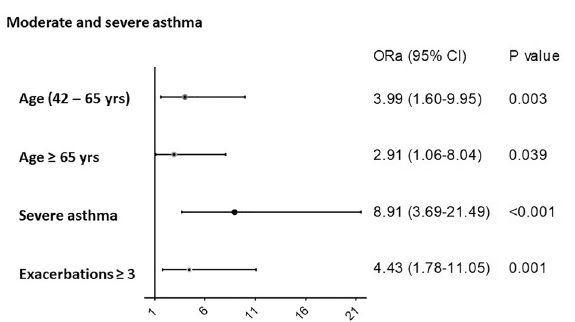
Figure 3. Factors associated with bronchiectasis in all subjects (moderate and severe asthma). ORa: adjusted odds ratio. CI: confidence interval. Model: χ 2 = 73.64, p < 0.001. Model adjusted by gender, atopy, sinusitis, nasal polyps, FVC% and FEV1%. Logistic regression was used to perform the